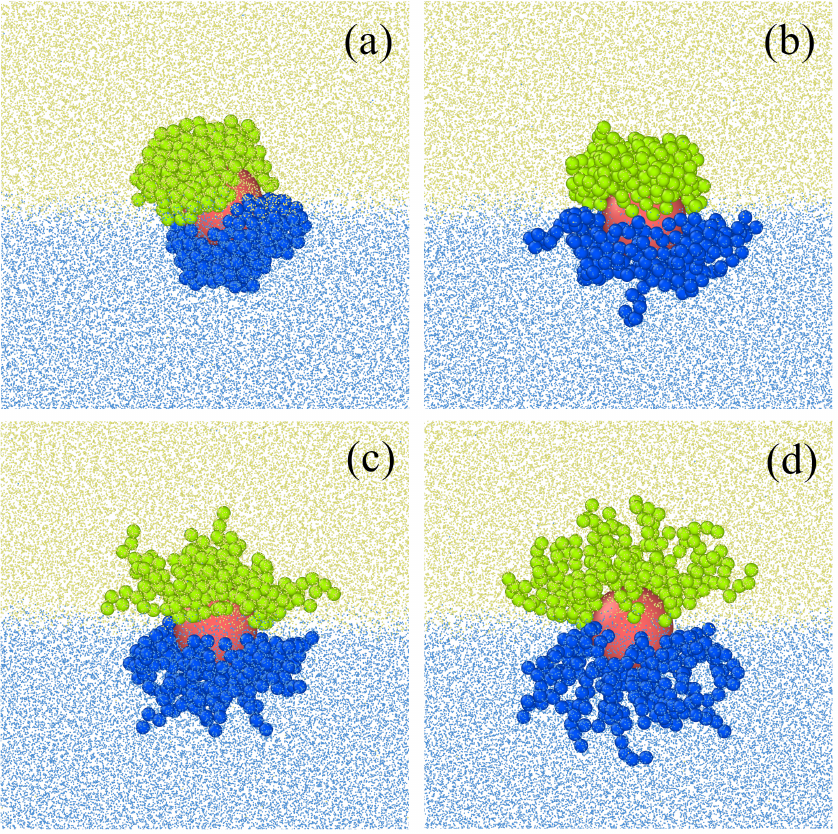
Figure 6. Examples of equilibrium configurations of Janus hairy particles obtained from molecular dynamics simulations. The Lennard-Jones parameters characterizing interactions of chains A (navy) = 0.5, ( b ) ε ∗ = ε ∗ = 0.5 with the fluid W, ε ∗ and chains B (green) with the fluid W, ε ∗ : ( a ) ε ∗ BO AW BO AW AW = 1, ( c ) ε ∗ = ε ∗ = 1, and ( d ) ε ∗ = ε ∗ = 1.5. Other interactions with chains are and ε ∗ BO AW BO AW BO assumed to be